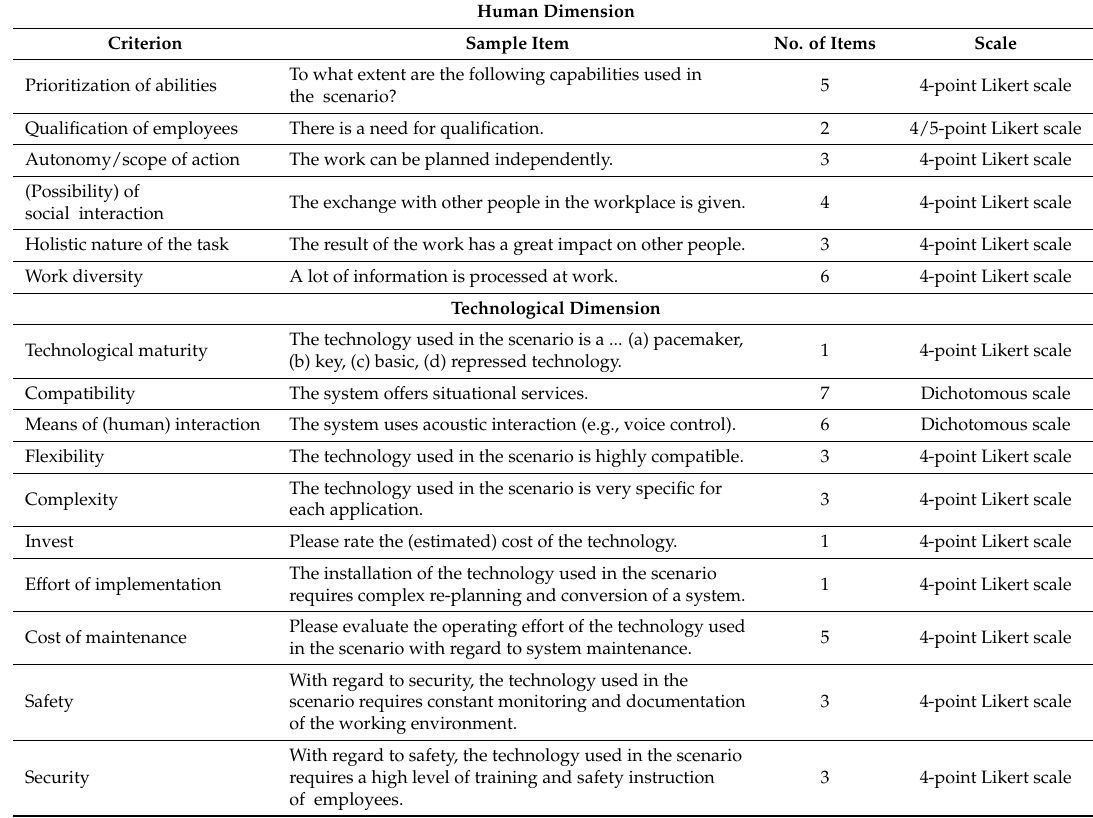
Table 2. Overview of used